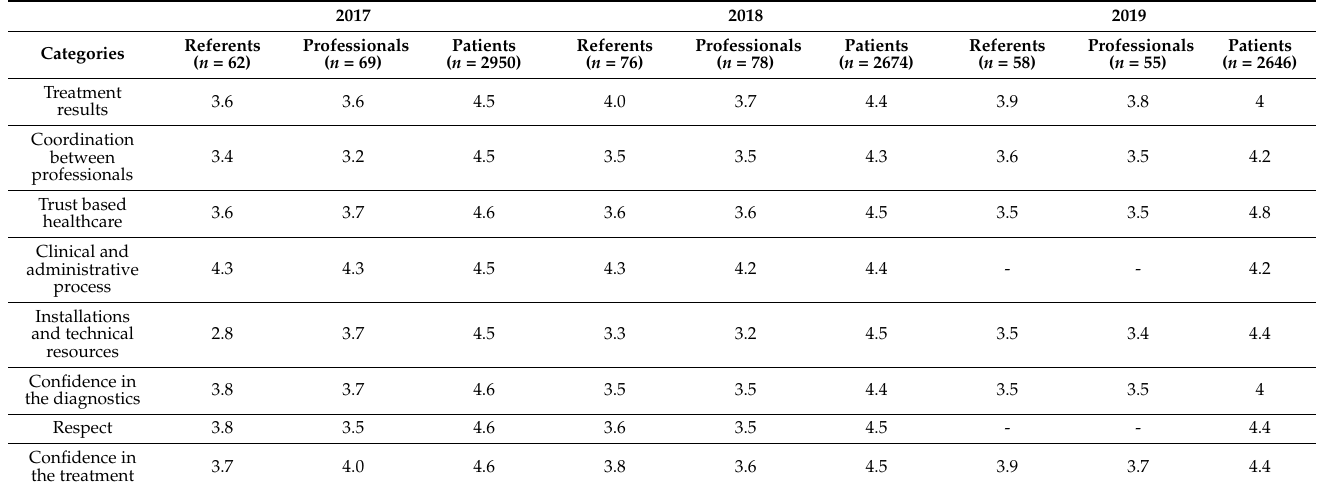
Table 2. Scoring of the categories in the study period of referents, professionals, and